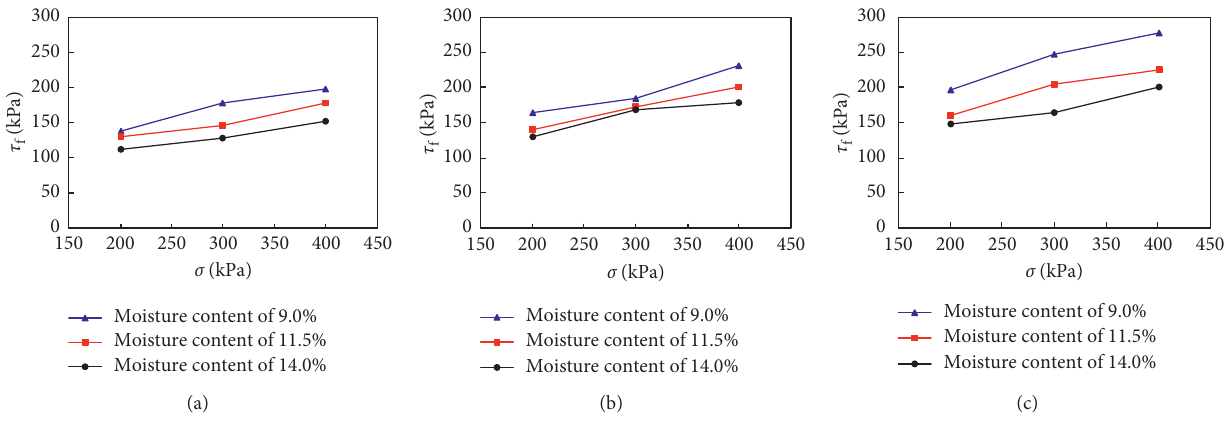
Figure 9: Relationship between shear strength ( τ